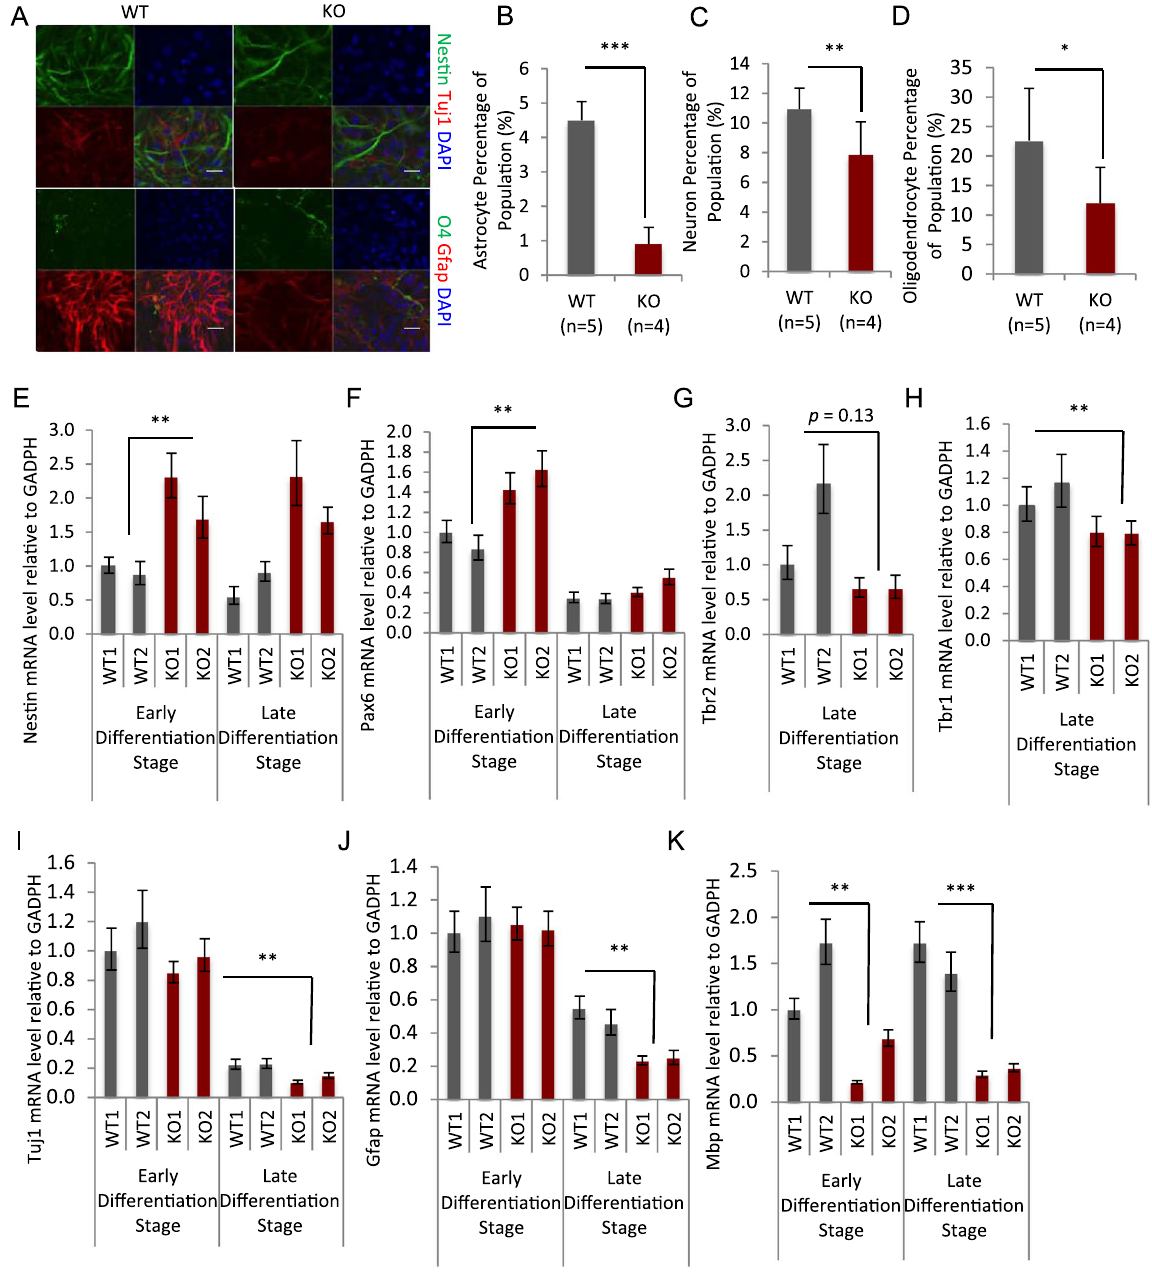
Figure 2. Delay of neural linage commitment in Lsh − / − NSPCs. ( A ) Immunofluorescence assay using neural linage markers in differentiated NSPCs in vitro using an undirected differentiation protocol. Magnification: 40x, Scale bar, 20 μ m. ( B , C and D ) Quantification of mature linages using lineage-oriented differentiation protocols through which NSPCs differentiated into one linage dominant populations: astrocyte ( B ), neuron ( C ) and oligodendrocyte ( D ), proportion measurement by FACS. See also Fig. S2. ( E and F ) mRNA level assessment of NSPCs progenitor markers by RT-qPCR: Nestin ( E ) and Pax6 ( F ). ( G and H ) mRNA level assessment of markers by RT-qPCR: Tbr2 ( G ) and Tbr1 ( H ). ( I , J and K ) mRNA level assessment of mature neural linage markers by RT-qPCR: Tuj1 ( I ) for neuron, Gfap ( J ) for astrocyte and Mbp ( K ) for oligodendrocyte. Early and late differentiation stage refers to differentiation for 3 and 6 days, respectively. Gapdh served as internal control, expression levels were relative to WT1 for each gene. Data are represented as mean ± SD. * p < 0.1, ** p < 0.05, *** p <